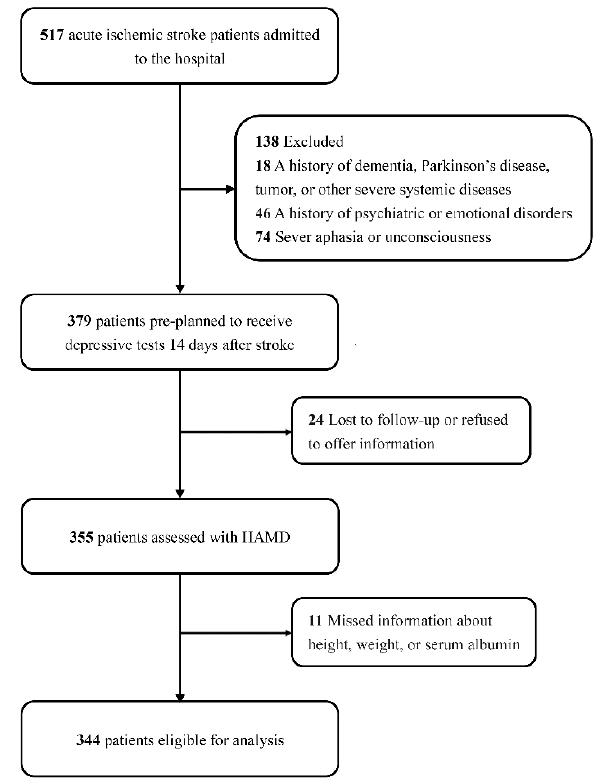
Figure 1. Study flow gram.